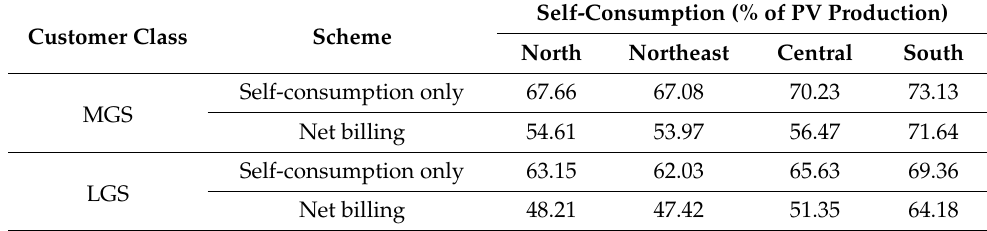
Table 5. Self-consumption level by region for MGS and LGS